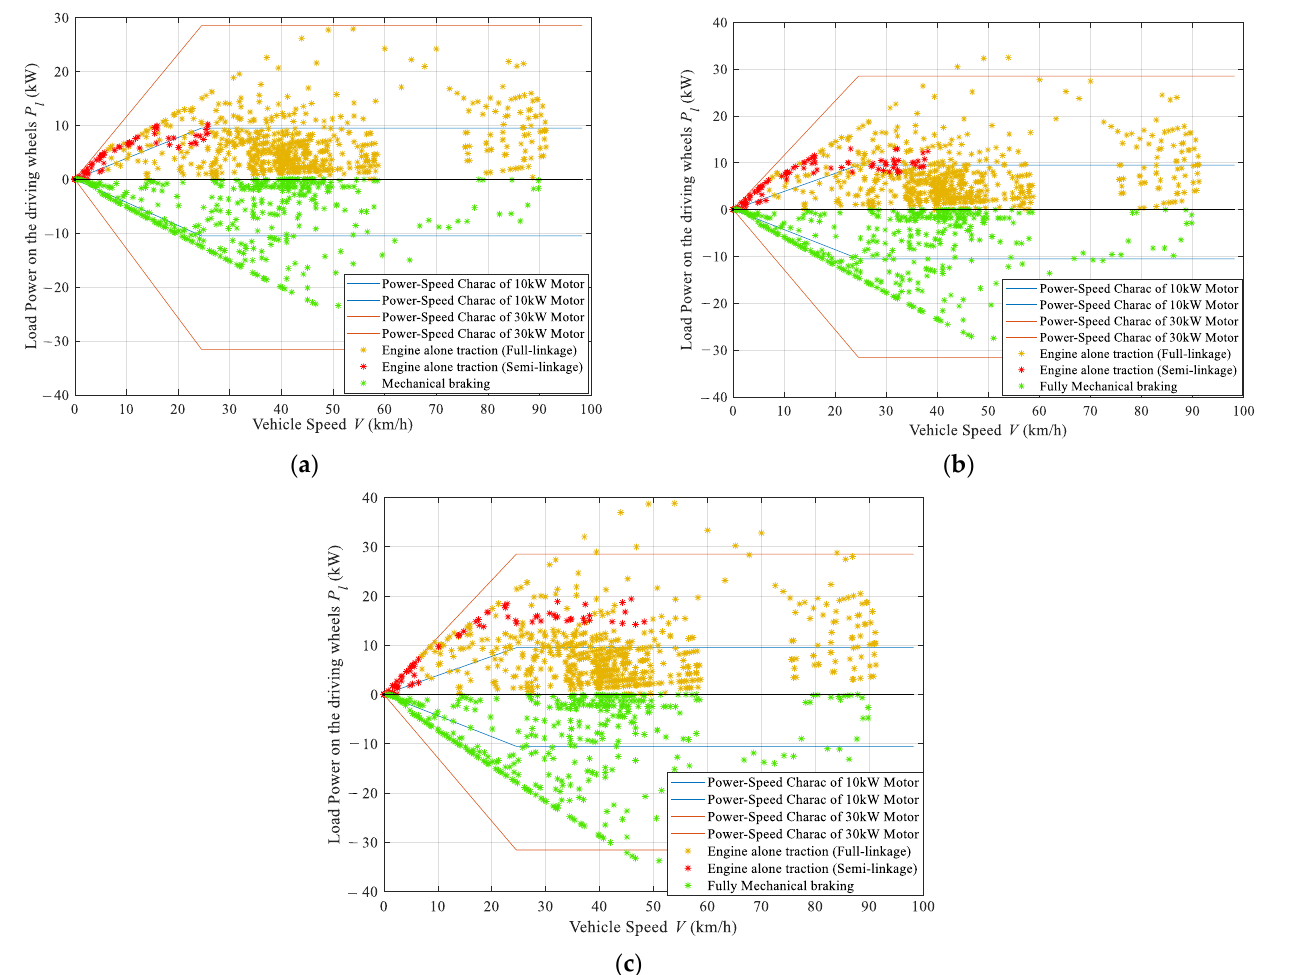
Figure 4. Load operating points during the FTP75 Urban driving cycle with respect to the power-speed characteristics of the 10 kW rated motor and of the 30-kW-rated motor for three typical IC engine vehicles: ( a ) Toyota Corolla 2019; ( b ) Toyota Camry 2016; ( c ) Chrysler 300 2016.